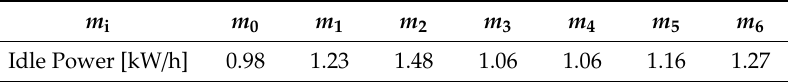
Table 4. Idle power of machines.